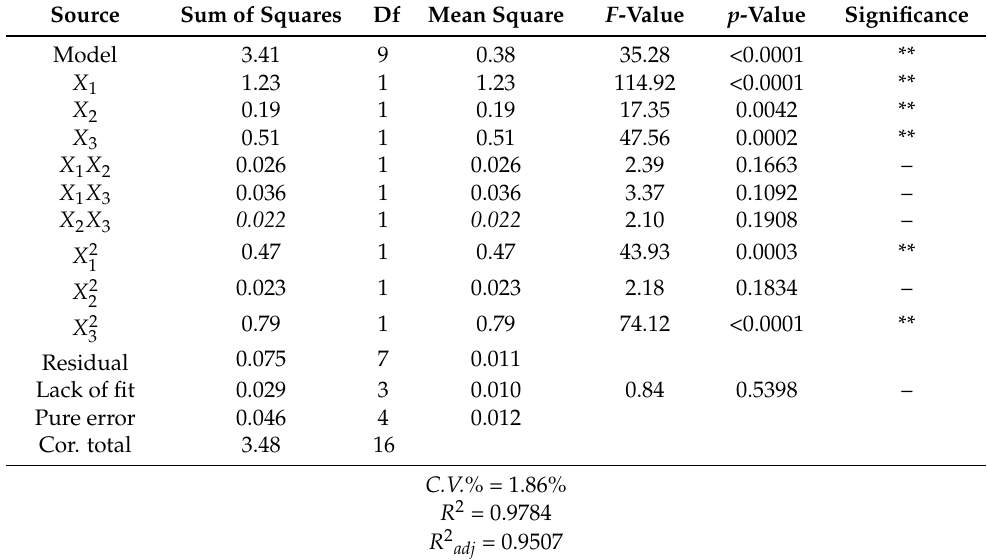
Table 2. Analysis of variance (ANOVA) results of the regression model for the extraction yield of RGP. Source Sum of